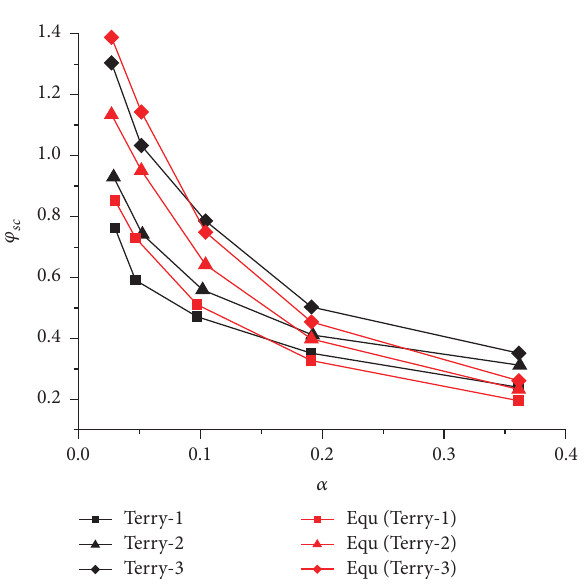
Figure 14: Composite creep coefficient compared with results of Terry et al.